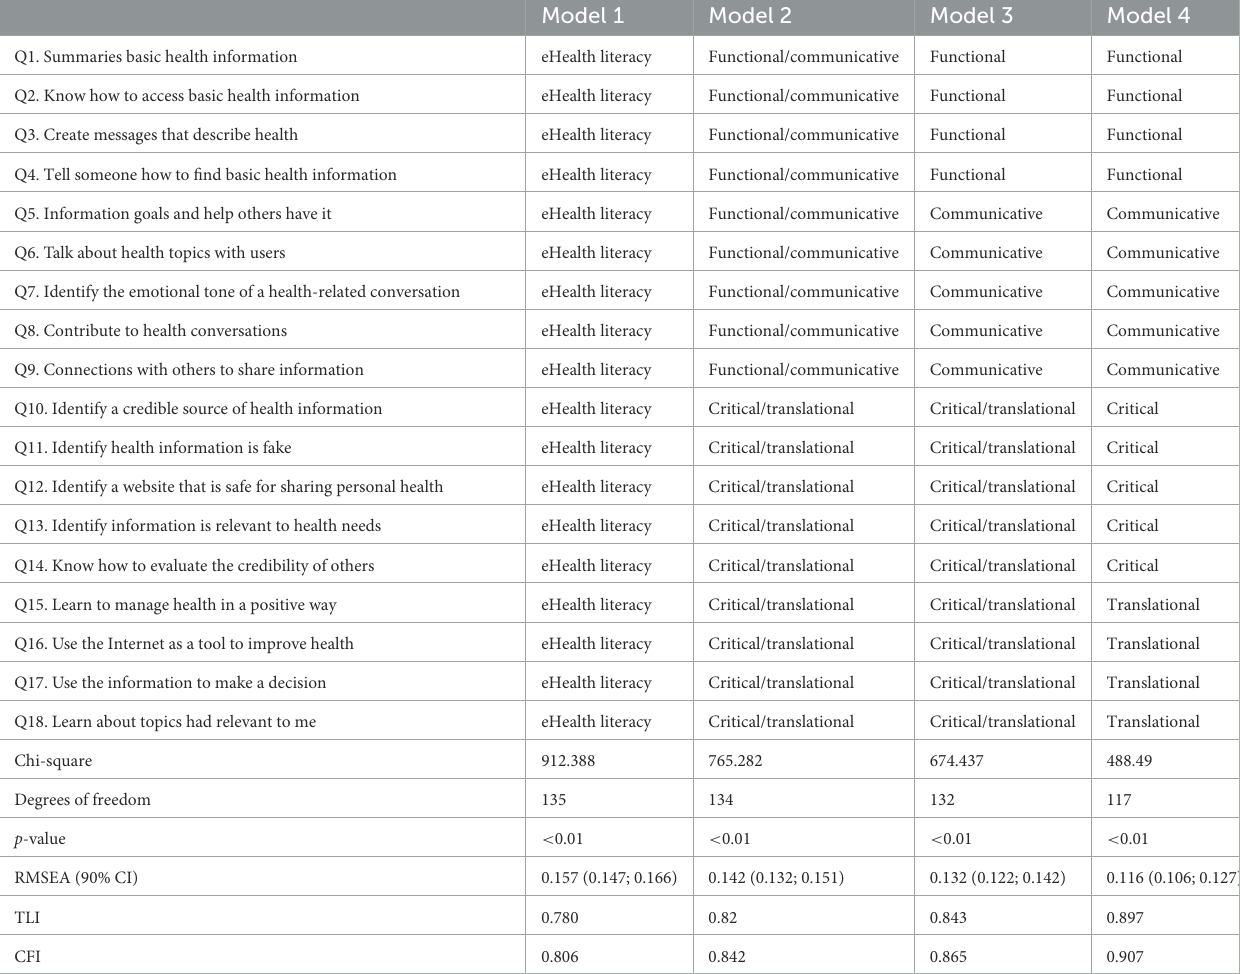
TABLE 4 Exploratory factor analysis and confirmatory factor analysis models and fit indices evaluating factor structure of the transactional eHealth literacy